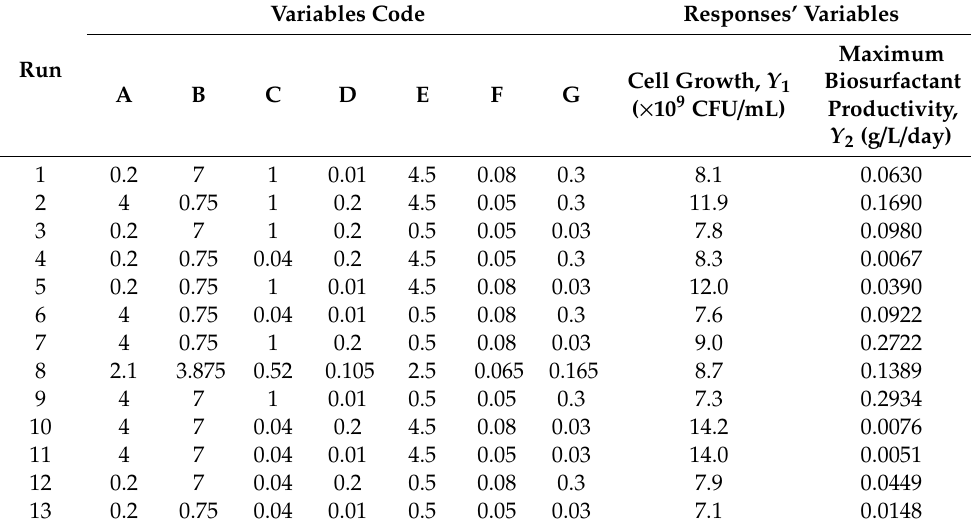
Table 3. Plackett–Burman experimental design for seven variables and the corresponding experimental response (cell growth and maximum biosurfactant